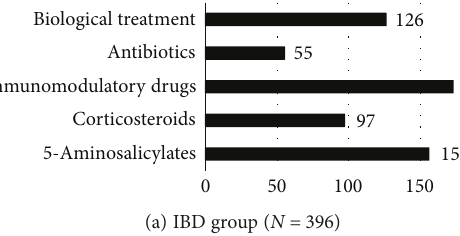
Figure 1: Concurrent medication in the IBD (a) and control group (b). IBD: in fl ammatory bowel